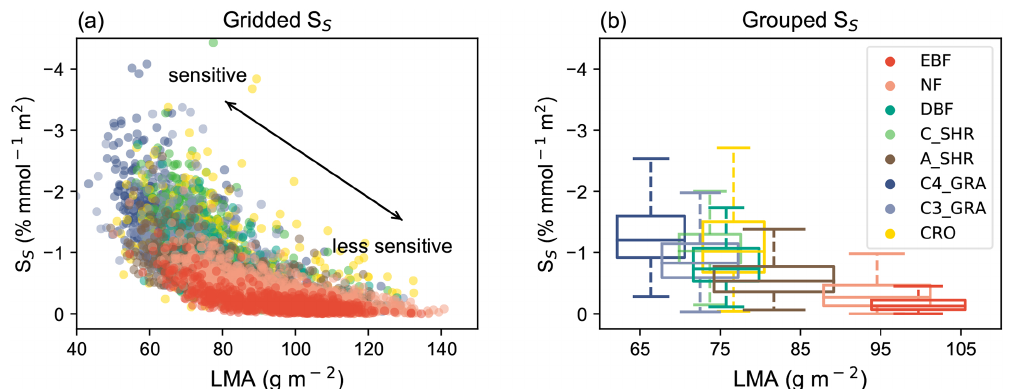
Figure 8. Relationships between O 3 sensitivity and LMA. (a) Simulated O 3 sensitivity ( S S ) at each grid is compared with LMA for different PFTs. Gridded S S is derived as GPP change per unit POD y = 1 from the YIBs-LMA simulation. Each point represents the value in a grid cell with a dominant PFT. (b) The PFT-level relationships between LMA and O 3 sensitivity are grouped as box plots, which indicate the median, 25th percentile, and 75th percentile of y -axis variables within the same PFT. The width of box plots represents 1 standard deviation of LMA for a specific PFT.